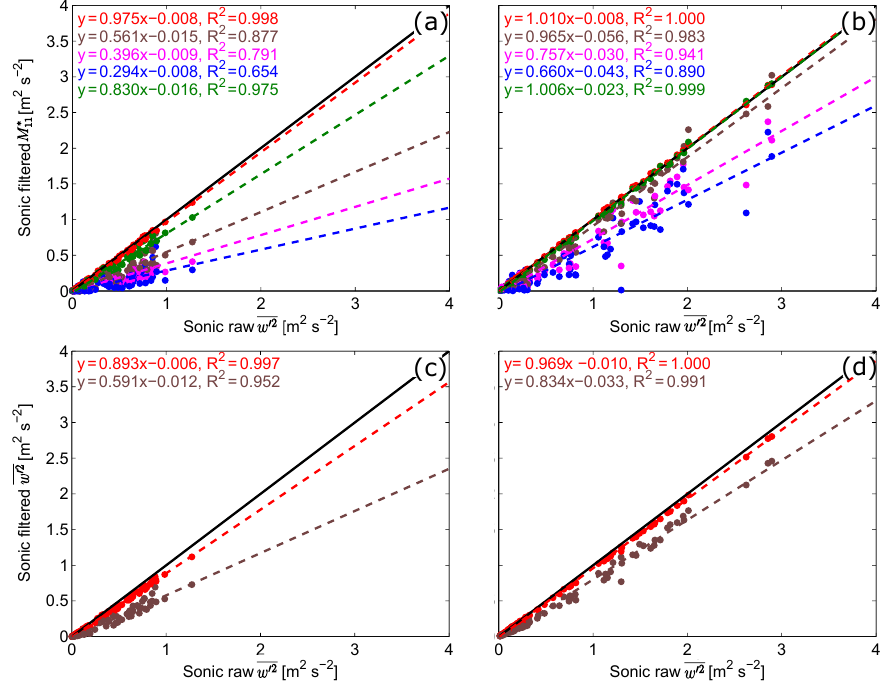
Figure 6. Relation of w (cid:48) 2 values computed from the raw 60Hz 30min sonic time series compared with those estimated as M ∗ filtered sonic anemometer data at 50 (a) and 300m (b) . Red and brown dots are the estimate from sonic data averaged to 1 and 0.1Hz respectively, after the fitting is applied using the specified number of lags discussed in Sect. 3.2. Magenta and blue dots are estimates of sonic data averaged to 1 and 0.1Hz respectively, after the fitting is applied using 100s of lag time. Green dots are the estimates from the 1Hz sonic data, using 10s of lag time for the fitting. Comparison of directly computed w (cid:48) 2 at 50 (c) and 300m (d) from the raw 60Hz compared and averaged observations averaged to 1 (red) and 10s (brown). Black line indicates a one-to-one relationship. The dashed lines show the linear regressions, with the equations for linear regression and coefficients of determination shown in the upper-left